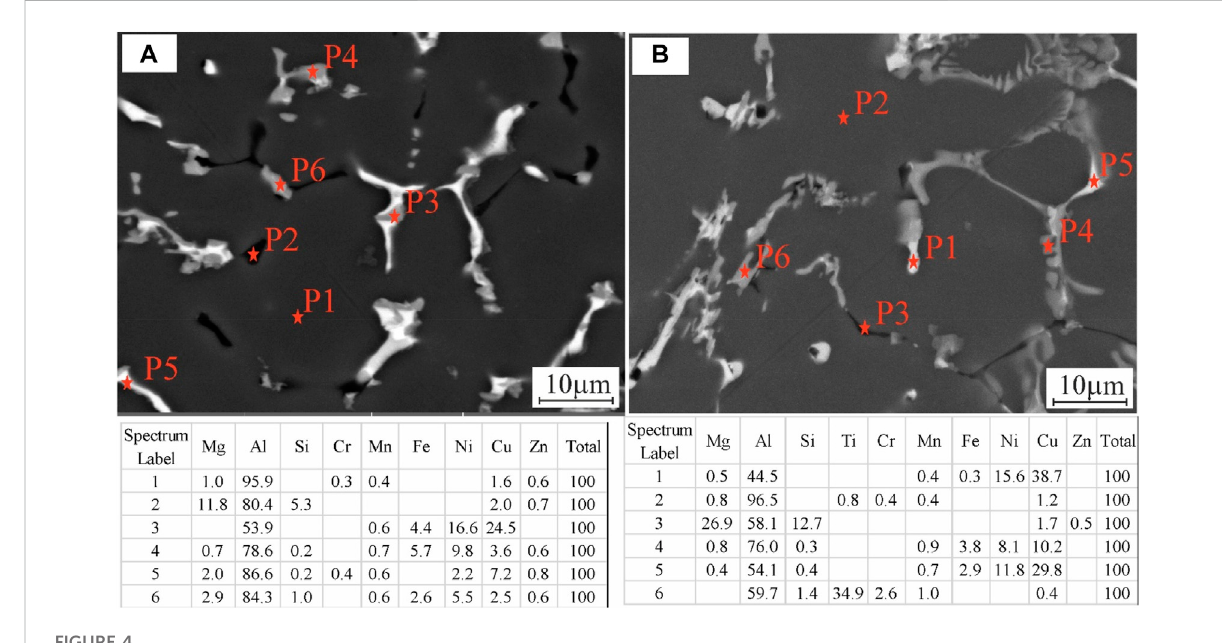
SEM Micro-images with corresponding EDS point analysis of: (A) standard and (B) modi fi ed A242 alloy.